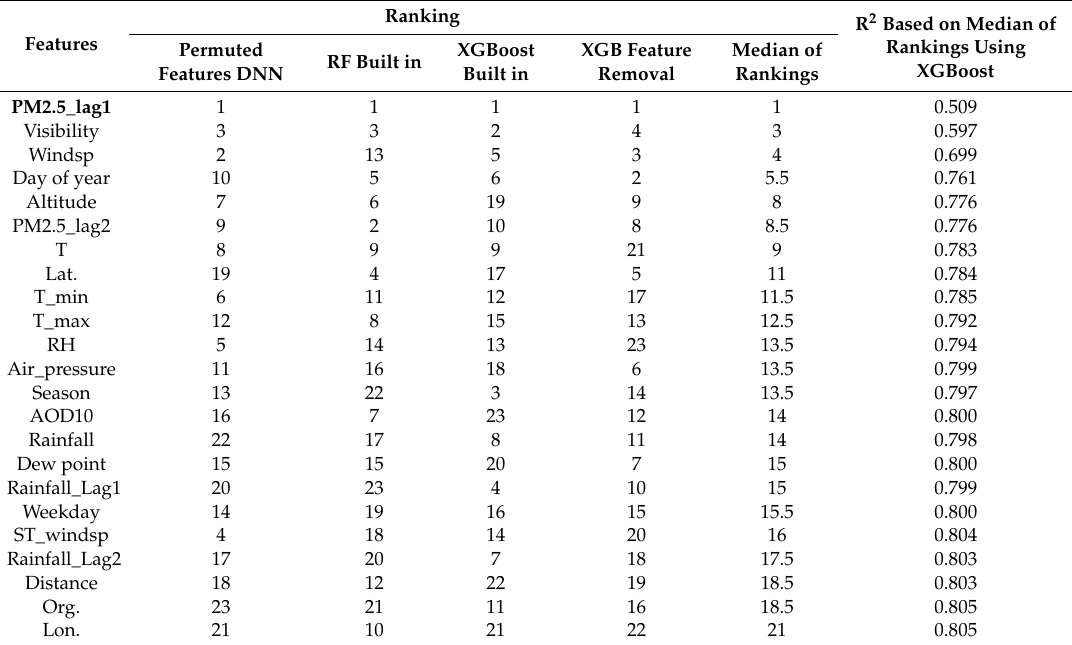
Table 7. Features importance ranking based on di ff erent modeling approaches. The median value of rankings for each feature is calculated and shown as a median ranking column. Features from top down are sorted based on median